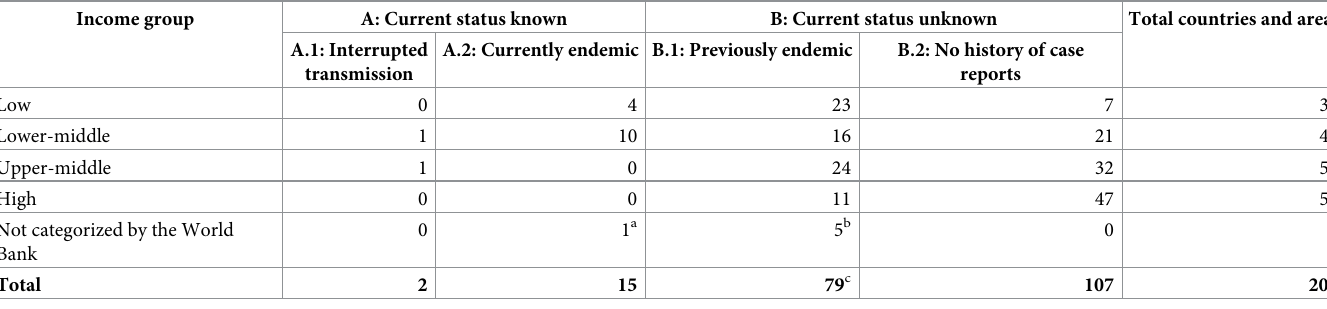
Table 3. Yaws endemicity status by World Bank income group, 2015. Income